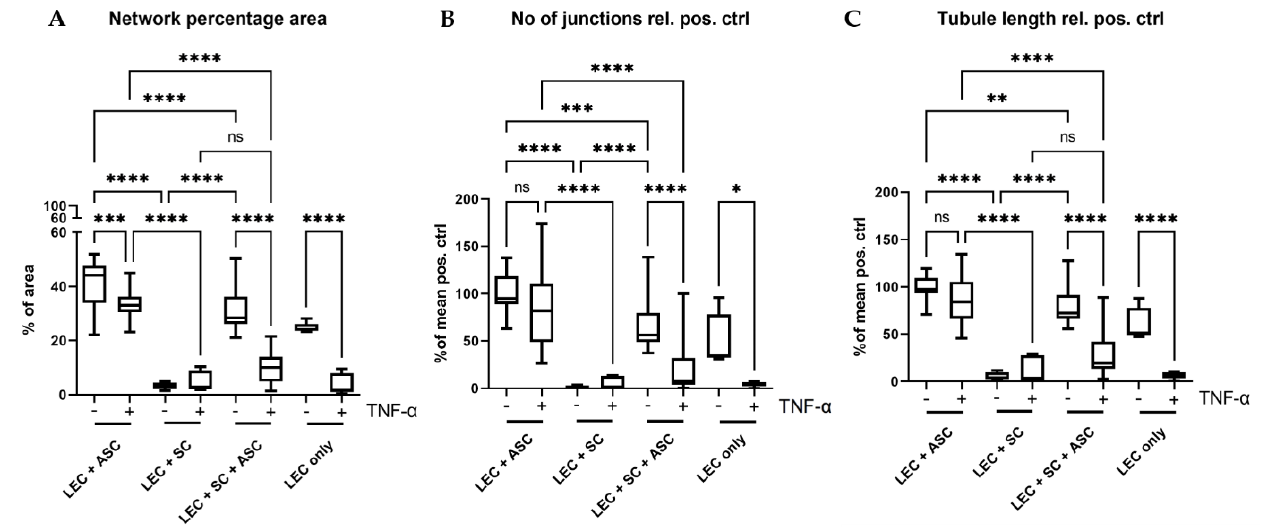
Figure 5. Quantification of the formed lymphatic networks in 3D fibrin clots. ( A ) Evaluation of the average area covered by lymphatic networks in percentage of total area. ( B ) Evaluation of the average number of junctions relative to the mean of the positive control (LEC + ASC). ( C ) Quantification of the average lymphatic tubule length relative to the mean of the positive control (LEC + ASC). In all parameters, the triple culture of LECs, SCs, and ASCs showed significantly lower levels than the positive control (LEC + ASC) ( A – C ). Co-culture of LECs with SCs inhibited network formation, whereas addition of ASCs reversed this effect. Furthermore, the effect of pro-inflammatory TNF- α on the formation of lymphatic networks was also evaluated. Here, we observed a larger negative effect of TNF- α on the triple -culture, when compared to the positive control in all parameters. LEC + ASC, LEC + SC and LEC + ASC + SC: n = 8 each of 4 independent experiments, LEC only: n = 4 of 2 independent experiments. * p < 0.05, ** p < 0.01, *** p < 0.001, **** p < 0.0001, ns not